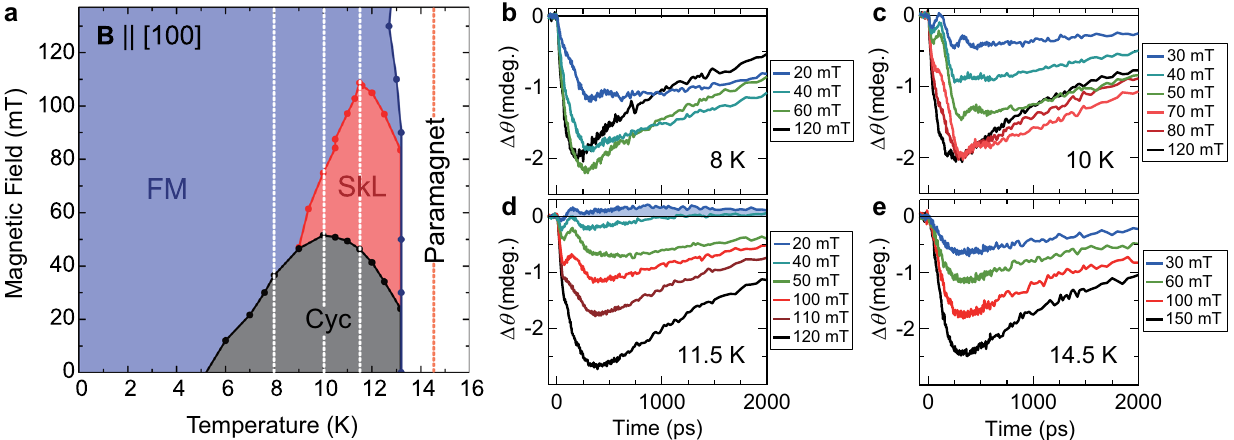
Fig. 1 Photoinduced Δ θ dynamics in the different magnetic phases of GaV 4 S 8 . a Magnetic phase diagram of GaV 4 S 8 . Vertical dashed lines indicate the temperatures where trMOKE measurements were performed. b – e Δ θ traces under different external magnetic fi elds at 8 K, 10 K, 11.5 K, and 14.5 K,